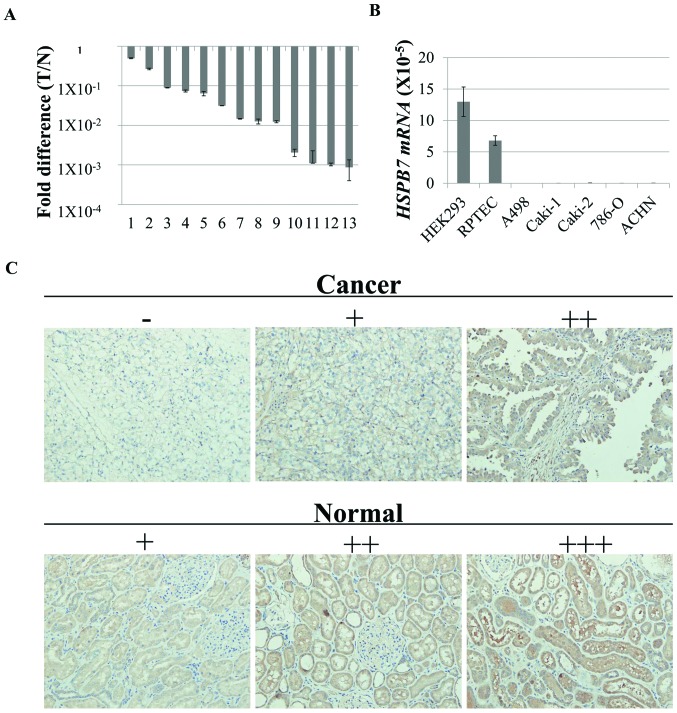
Downregulation of HSPB7 in RCC. qPCR analysis shows that HSPB7 mRNA expression was significantly downregulated (A) in 11 (85%) of 13 RCC tissues compared with the normal renal tissue, and (B) in all the five RCC cell lines compared with normal HEK 293 and RPTEC cells. T and N represent RCC tissue sample and normal renal tissue, respectively. B2M (β2 microglobulin) was used for normalization of expression levels. Values are expressed as the mean ± SD. (C) IHC analysis of a tissue array consisting of 11 pairs of human RCC sample reveals that the expression of HSPB7 was significantly higher in normal kidney tissues than in RCC tissues. According to the intensity of HSPB7 staining, these samples were evaluated as: negative (−), weakly positive (+), moderate positive (++), and strong positive (+++). HSPB7 negative or weakly positive (−/+) were considered low expression, and moderate or strong positive were considered high expression (++/+++). Summary of the IHC results is shown in Table I.